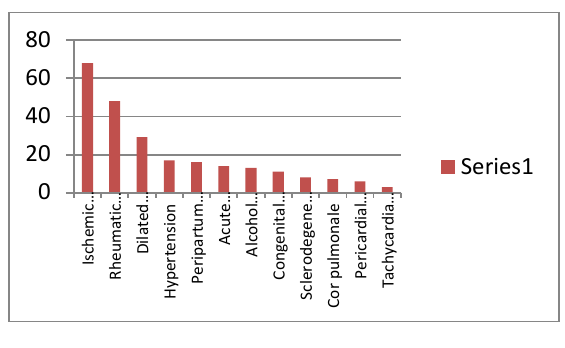
Figure 1. Etiologies of heart failure.